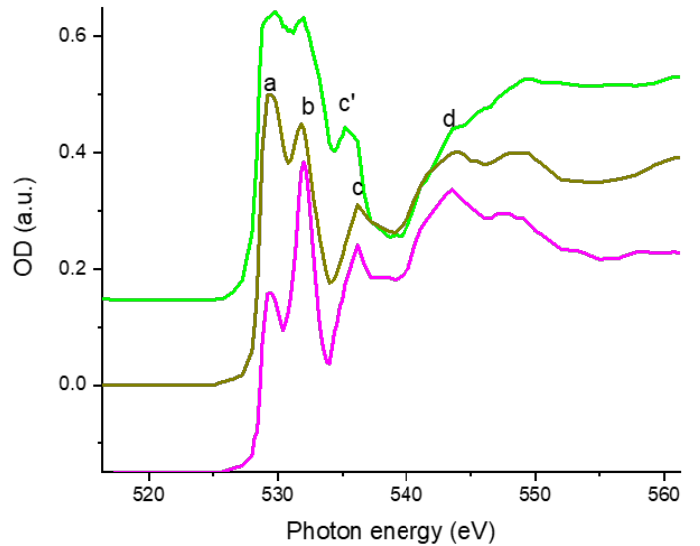
Figure 6. O K-edge XANES of the surface and bulk of large particles and small particles of LiMn 1.4 Ni 0.5 Ti 0.1 O 4 from Figure LiMn 1.4 Ni 0.5 Ti 0.1 O 4 from Figure 5.